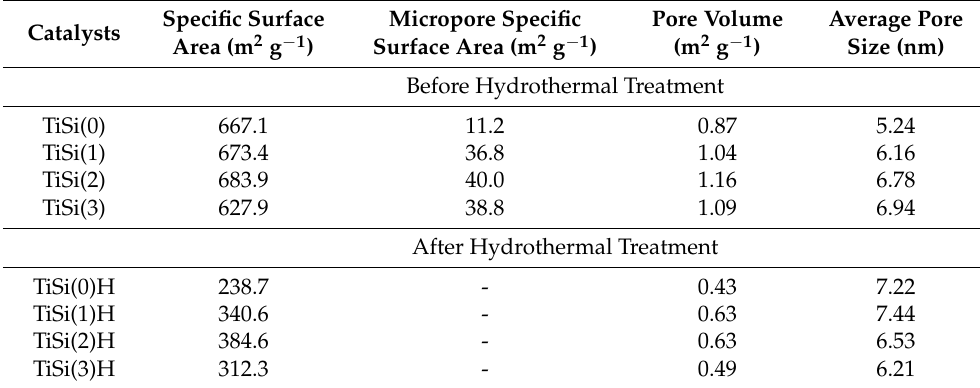
Figure 1. Nitrogen adsorption–desorption isotherms and pore size distribution curves of mesoporous silica catalysts with different titanium contents: ( a , b ) before hydrothermal treatment, ( c , d ) after hydrothermal treatment. Table 2. Physical and structural properties of mesoporous silica with different contents.